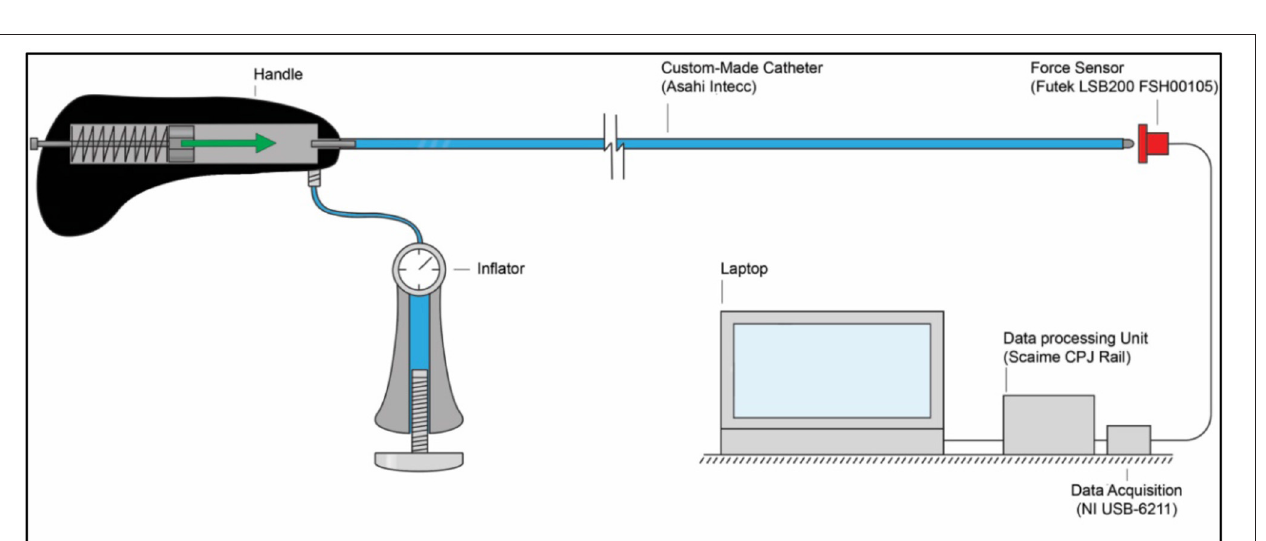
FIGURE 7 | Catheter shaft design. From left to right: (1) isometric projection of the open coil catheter shaft without PTFE liner, (2) isometric projection of the closed coil catheter shaft without PTFE liner, (3) isometric projection of the closed coil catheter shaft with PTFE liner, and cross-sectional front view of the catheter shaft without PTFE liner. Color indications: blue = flat wire coil, green and yellow = double internal braiding, red = nylon outer coating, and light blue = PTFE liner.